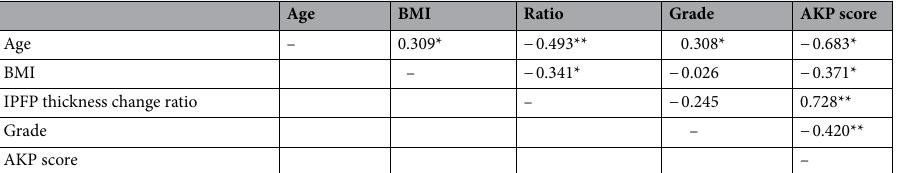
Table 2. Correlation coefficients between characteristics of patients and AKP scores. AKP anterior knee pain, BMI body mass index, IPFP infrapatellar fat pad. *: P < 0.05, **:P < 0.01.